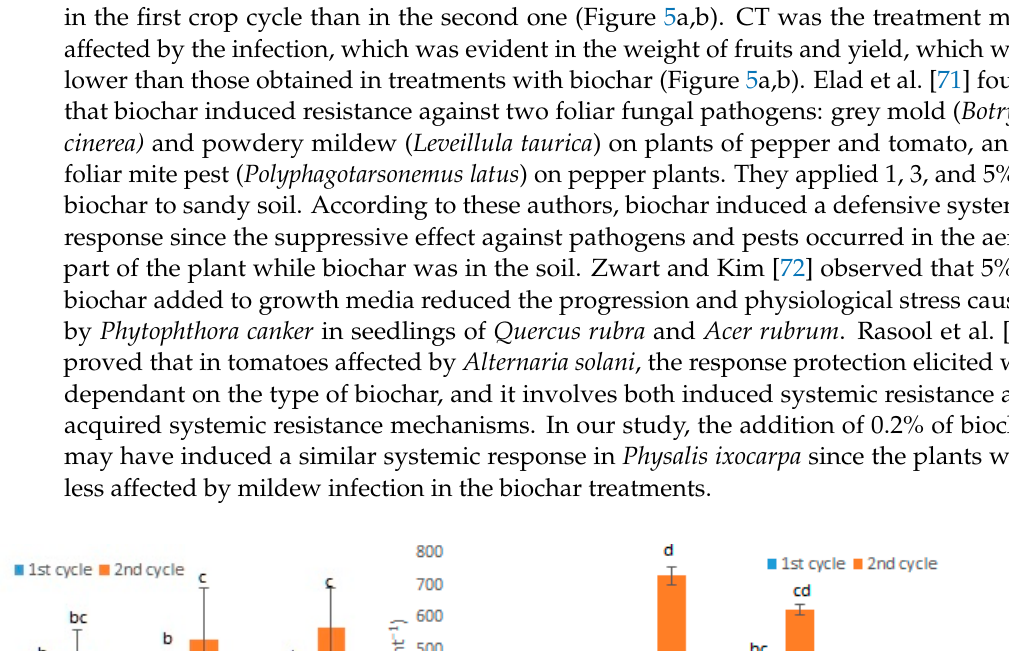
Figure 6. ( a ) Plant height and ( b ) root length of Physalis ixocarpa with different treatments: CT: soil + 100% of chemical fertilization, BT20 and BT50: soil + biochar +, 20, or 50% of chemical fertilization, respectively, and BBfT: soil + biochar + biofertilization. Different letters indicate significant difference ( p < 0.05, Duncan test).